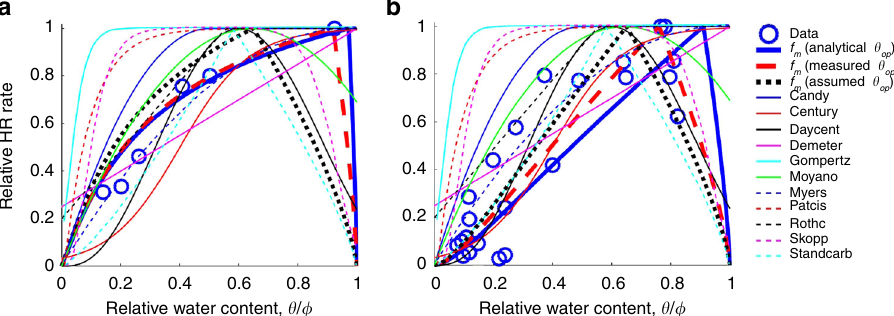
Fig. 7 Applications of the moisture function, f m , to laboratory and fi eld observations. Comparisons of f m with measured heterotrophic respiration (HR) – moisture relationships for a sandy loam in laboratory incubations 10 and b loam in fi eld observations 25 . The coarse blue solid lines are the predicted HR – moisture relationship using f m with a = 2.8 c c − 0.046, b = 0.75, and θ op calculated by Eq. (11) in Methods section. The coarse red dash and black dotted lines represent f m using the same a and b values as in the coarse blue solid lines but measured θ op and assumed θ op , θ op = 0.65 ϕ , respectively. Other lines represent widespread empirical moisture functions commonly used in Earth system models (see Supplementary Table